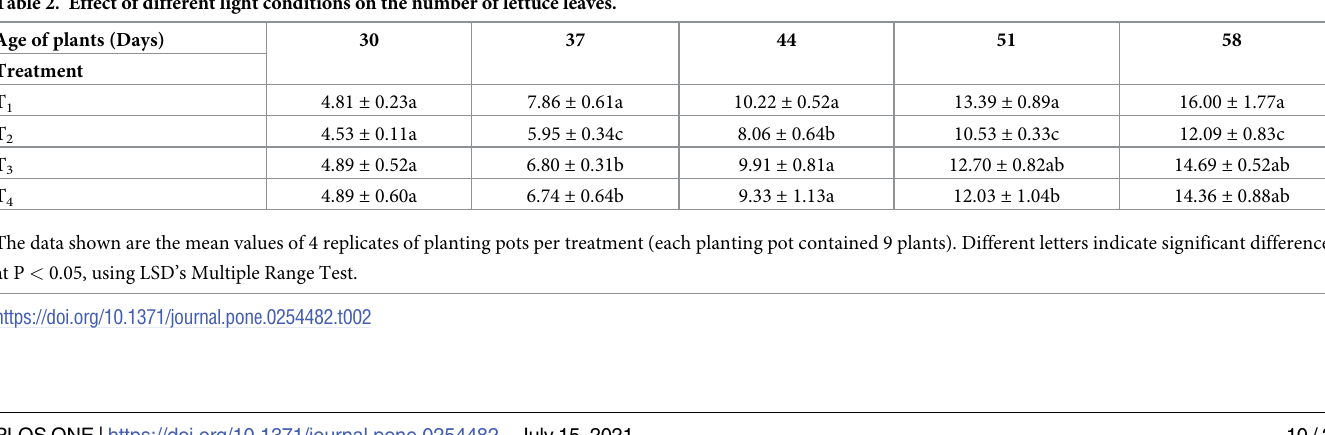
Table 2. Effect of different light conditions on the number of lettuce leaves. Age of plants (Days)